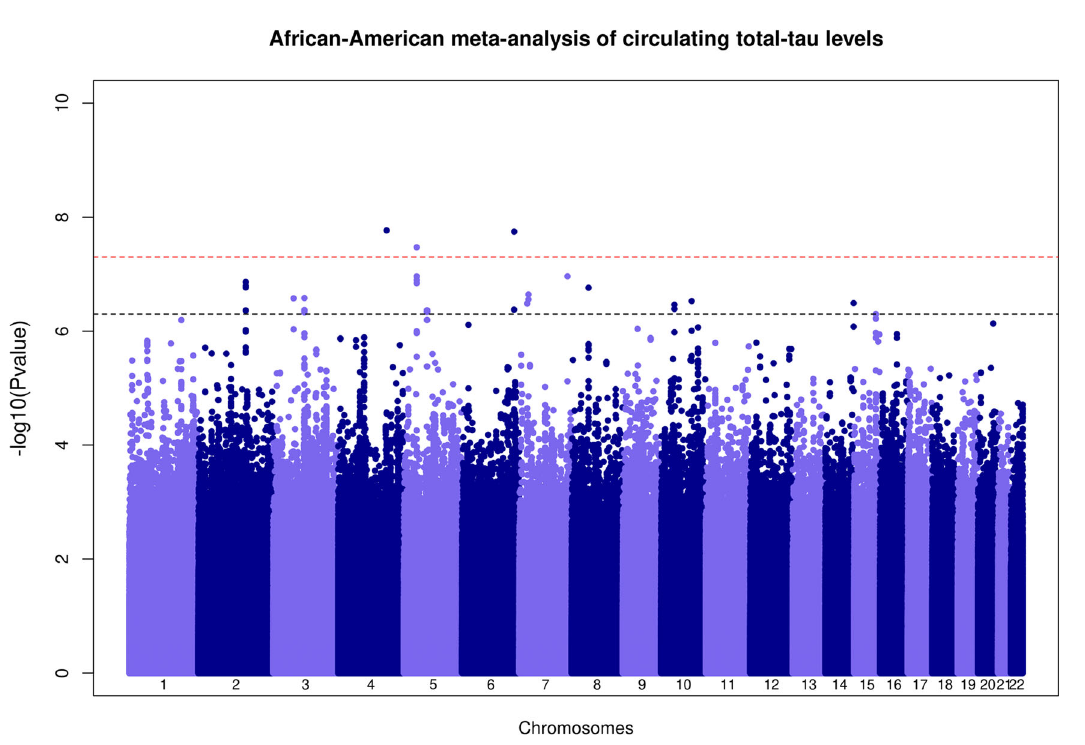
Fig. 1 Manhattan plot of association P values for the African American speci fi c meta-analysis of GWAS of circulating total-tau levels. The – log10( P )- value for each single nucleotide variant on the y axis is plotted against the build 37 genomic position on the x axis (chromosomal coordinate). The dashed horizontal red line indicates the genome-wide signi fi cance threshold of P = 5 × 10 − 8 and the dashed horizontal black line indicates the threshold of P = 5 × 10 − 7